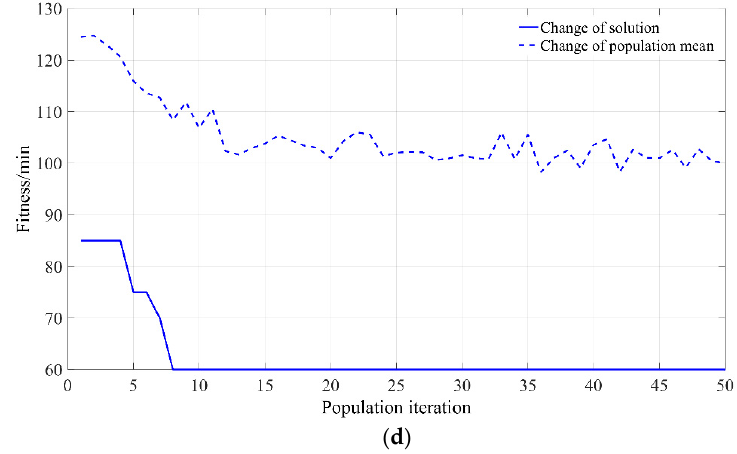
Figure 10. Change of population fitness value. ( a ) 3 aircraft, ( b ) 4 aircraft, ( c ) 5 aircraft, ( d ) 6 aircraft. Table 8. Support vehicles utilization and completion time of three operations.